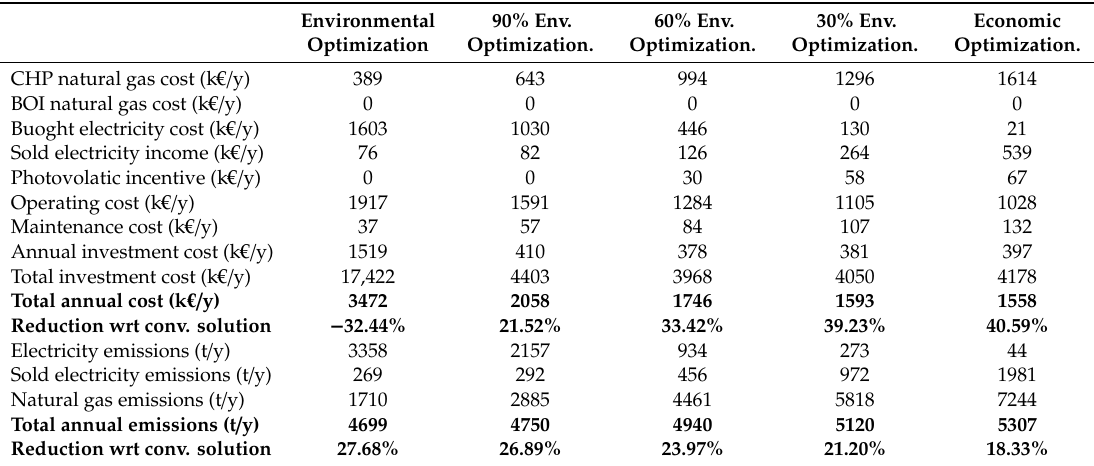
Table 10. Total economic and environmental results of the optimizations—distributed generation